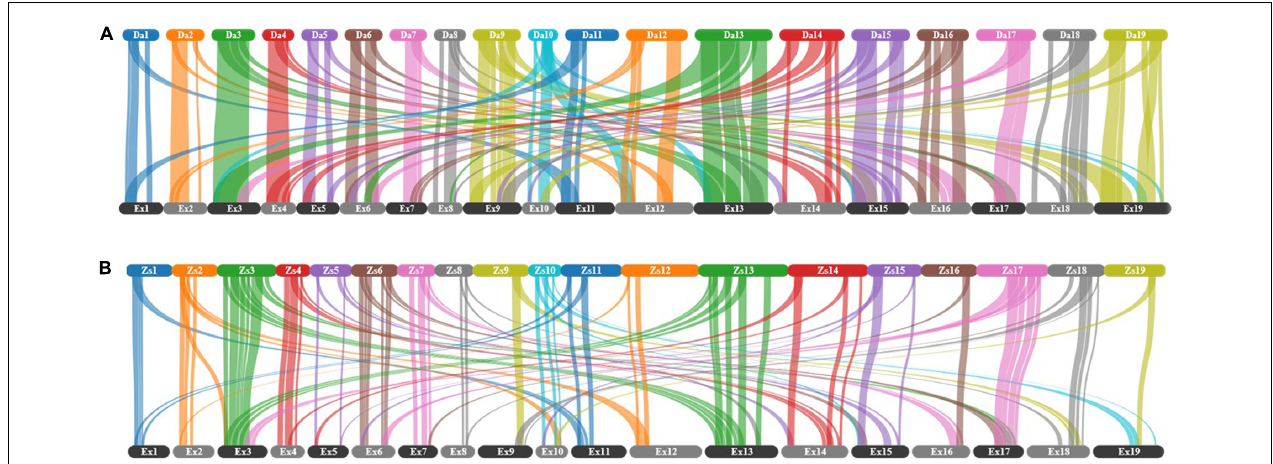
FIGURE 2 | Collinearity between Express 617 and two other B. napus assemblies for all chromosomes. (A) Darmor -bzh v4.1 versus Express 617, (B) ZS11 versus Express 617. Collinear blocks are indicated as connecting bars between genomes. The chromosomes were labeled with two letter indicating the cultivar followed by chromosome number, where 1 to 10 corresponds to chromosomes A1 to A10 and 11 to 19 corresponds to chromosomes C1 to